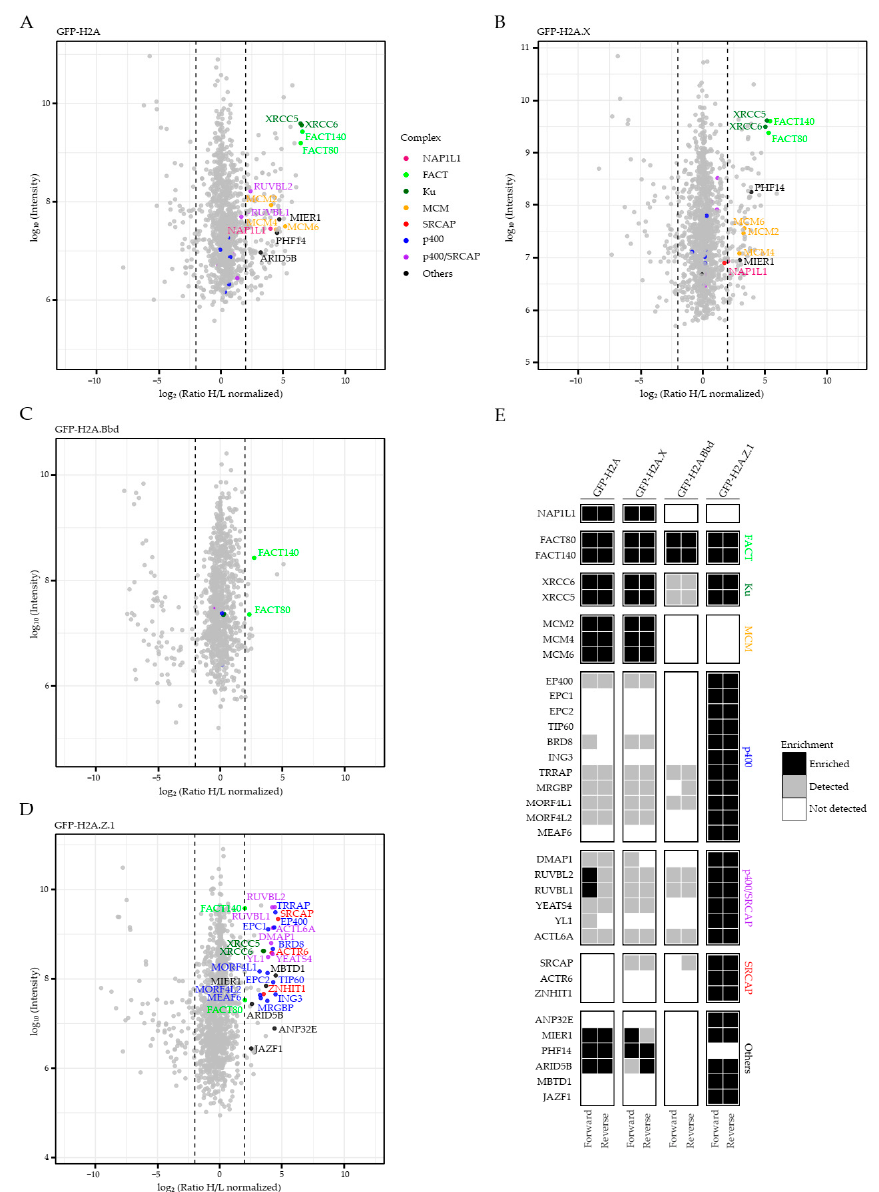
Figure 1. JAZF1 is member of H2A.Z chaperone complex(es). ( A–D ) Scatter plots of Green Fluorescent Protein (GFP) pull- downs for GFP–H2A ( A ), GFP–H2A.X ( B ), GFP–H2A.Bbd ( C) and GFP–H2A.Z.1 ( D ) . HeLa Kyoto cells stably expressing GFP–H2A, –H2A.X, -H2A.Bbd or GFP–H2A.Z.1 were SILAC-labeled and subjected to single-step affinity purifications of soluble nuclear proteins, using GFP nanotrap beads. In each panel, the ratio of the identified proteins after MS is plotted. Nucleosome-assembly protein 1-like 1 (NAP1L1) is plotted in pink, members of the facilitates chromatin transcription (FACT) complex are depicted in bright green, members of the Ku complex in dark green, mini chromosome maintenance (MCM) proteins in orange, members of the SRCAP complex in red, of the p400 complex in blue and shared members of both complexes in purple. Other proteins are highlighted in black. Significantly enriched proteins of the abovementioned categories are labeled with names, non-significantly enriched but detected proteins are only highlighted with the respective color within the plot. Dotted lines represent selected ratio cutoff of 4 and 0.25. Shown is one out of two similar replicates. See Supplementary Materials Table S1 for a list of all identified proteins. ( E ) Heatmap of all identified chaperone proteins described in ( A – D ). Shown are enriched (black), detected but not enriched (gray) and not detected (white) proteins after forward or reverse SILAC–MS identifications. In forward and reverse experiments, selected ratio cutoff is 4 and 0.25, respectively. Shown is one of two similar biological